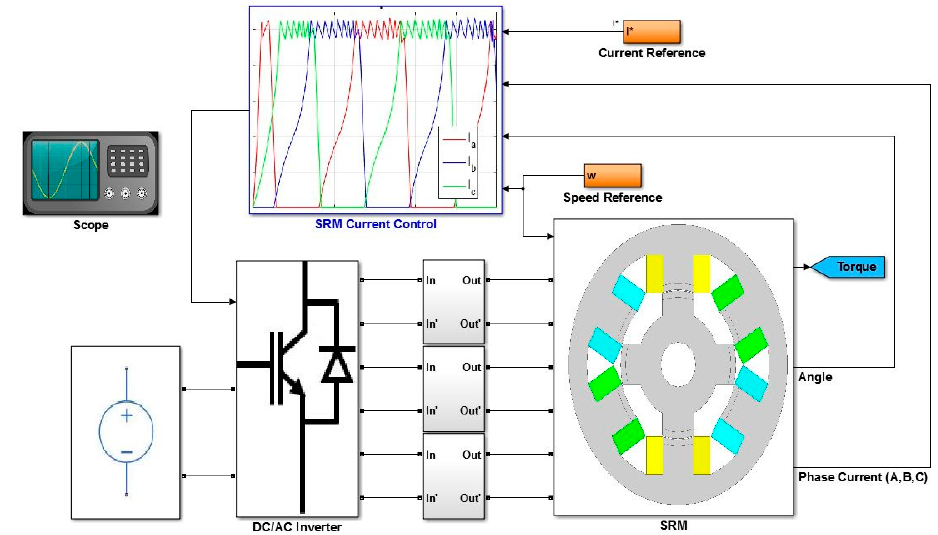
( b ) Figure 6. FEM simulation results: ( a ) torque map of a machine phase as a function of current and angle; ( b ) flux map of a machine phase as a function of current and angle.